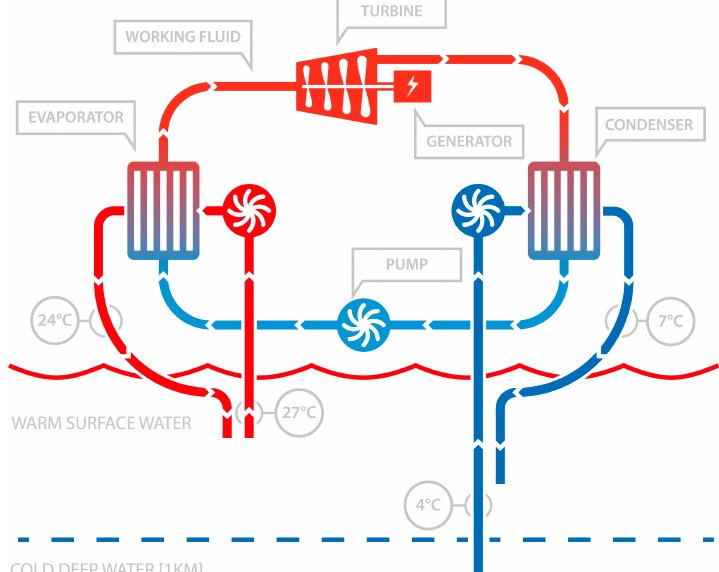
Figure 4. OTEC operation principle. [Source: OTEC working principle by Bluerise BV, retrieved from https://commons.wikimedia.org/wiki/File:OTEC_working_principle.jpg. Used under Creative Commons Attribution-Share Alike 4.0 International